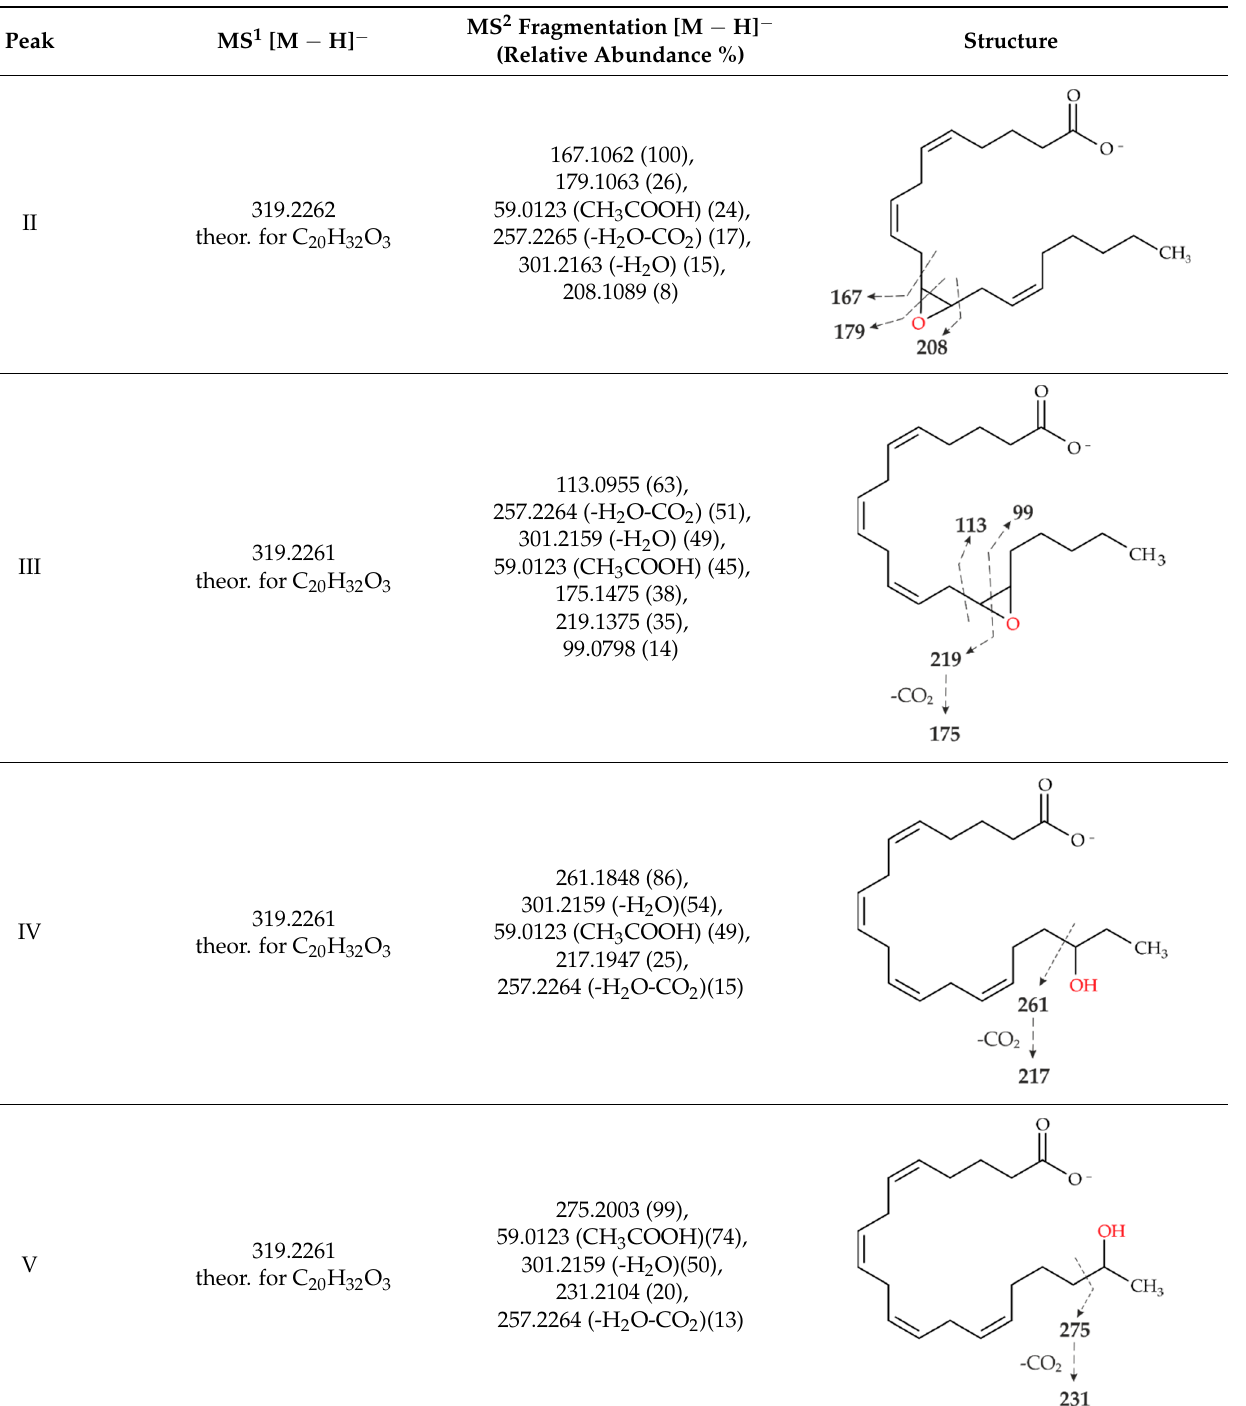
Table 2. MS 1 and MS 2 signals (in negative ionization mode) of the four major metabolites of AA formed by UPOs.